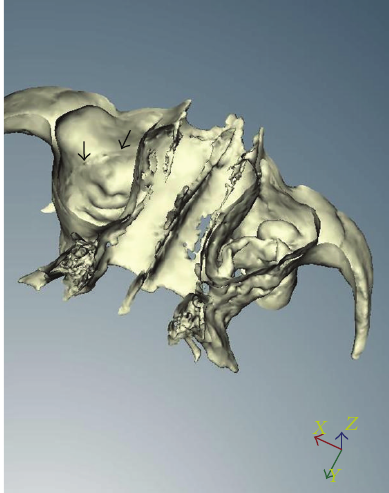
Figure 2: Three-dimensional reconstruction of the bony canal (black